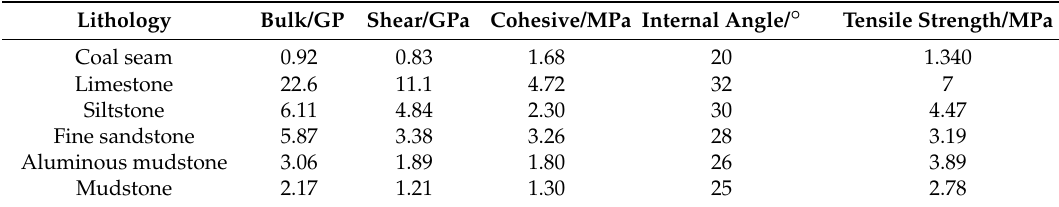
Table 1. Mechanical properties of rock